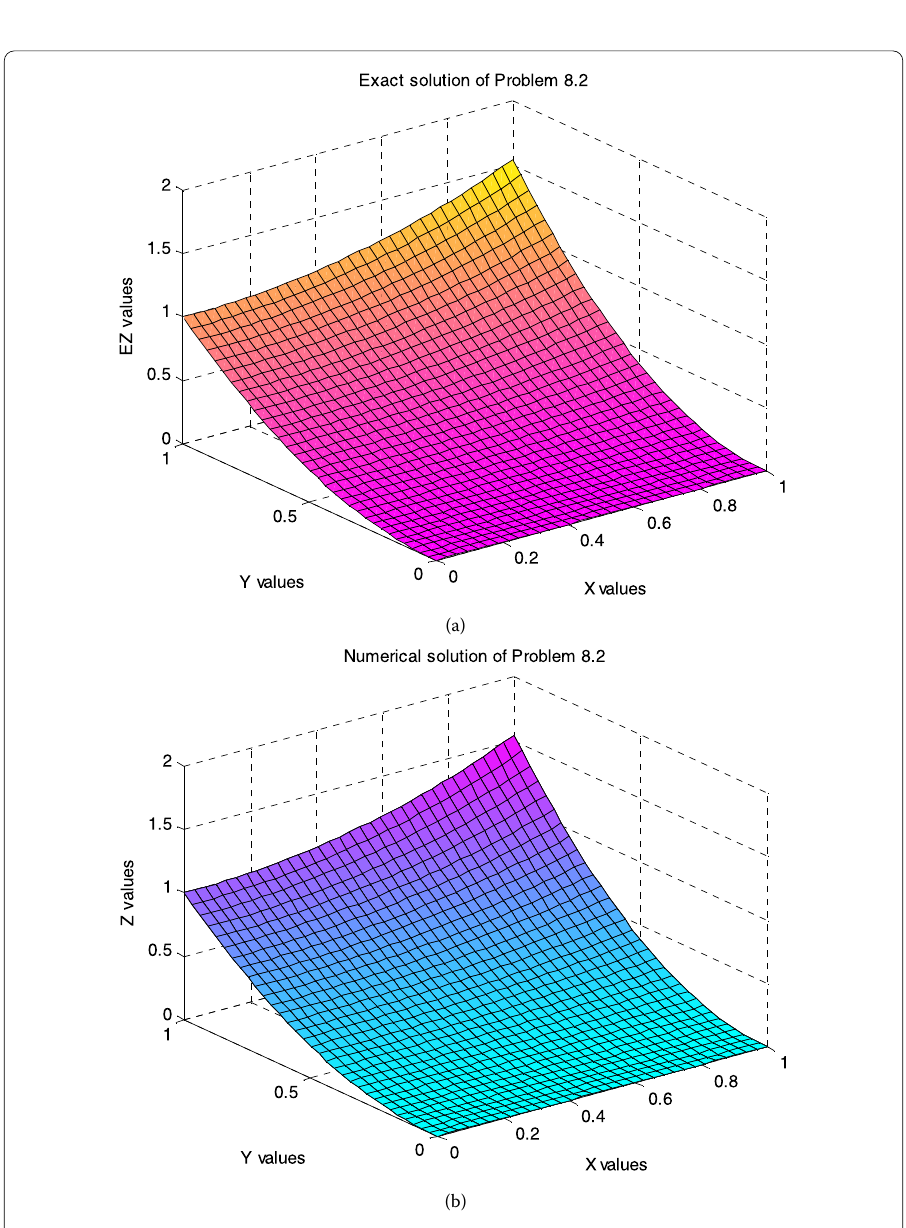
Figure 3 ( a ) Exact solution of Problem 8.2 for h = 1/32 and α = 2. ( b ) Numerical solution of Problem 8.2 for h = 1/32 and α =